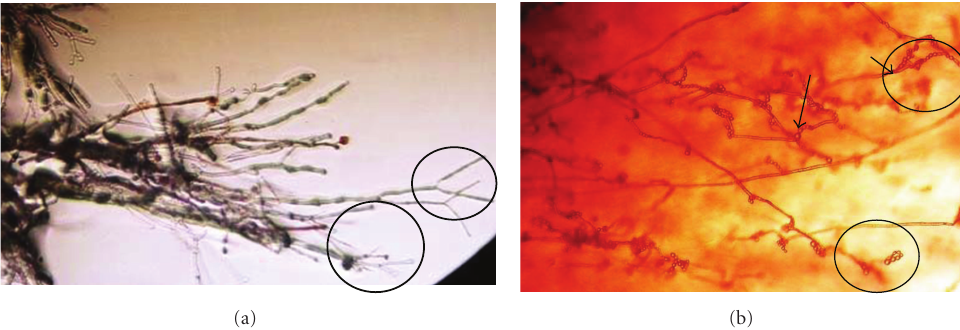
Figure 3: The number of conidia on PDA (a) and Hiroi (b) for DSM1379. Arrows indicated the conidiation (a few conidium on PDA (a) and improvement of conidiation on Hiroi medium (b)).